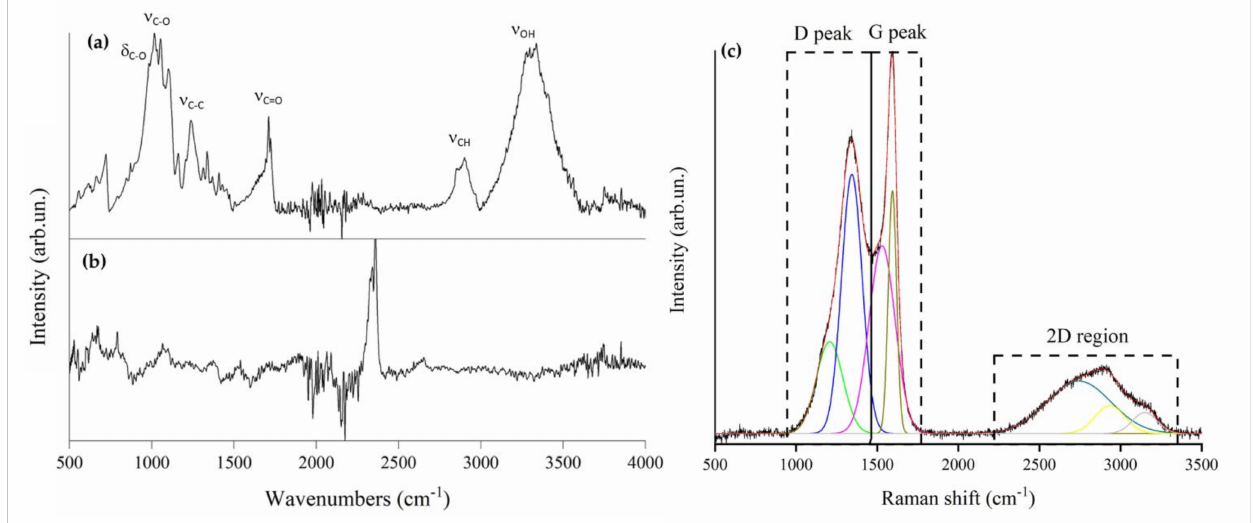
Figure 2. Spectroscopic analysis of neat cotton fibers and WC. FT-IR (ATR mode) spectra of ( a ) neat cotton fibers, ( b ) WCB, and ( c ) Raman spectrum of WCB (black line original signal, red line fitted spectrum, colored lines fitting